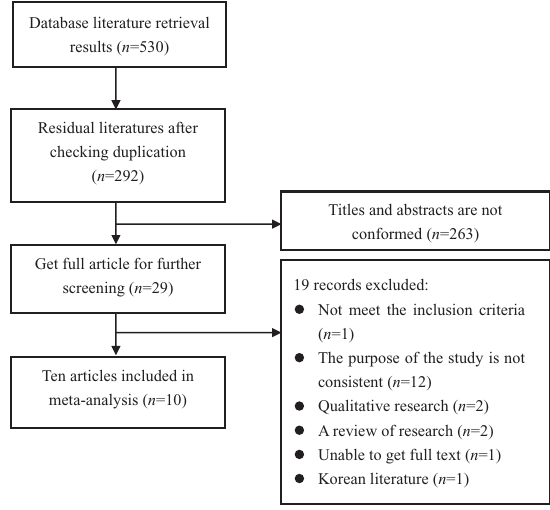
Figure 1. Flow chart of the study selection